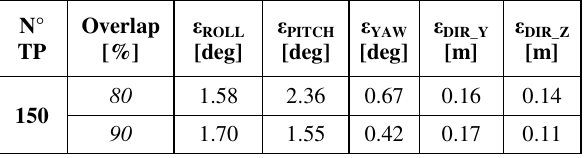
Table 11. Error propagated – 50 TP – simulation 4